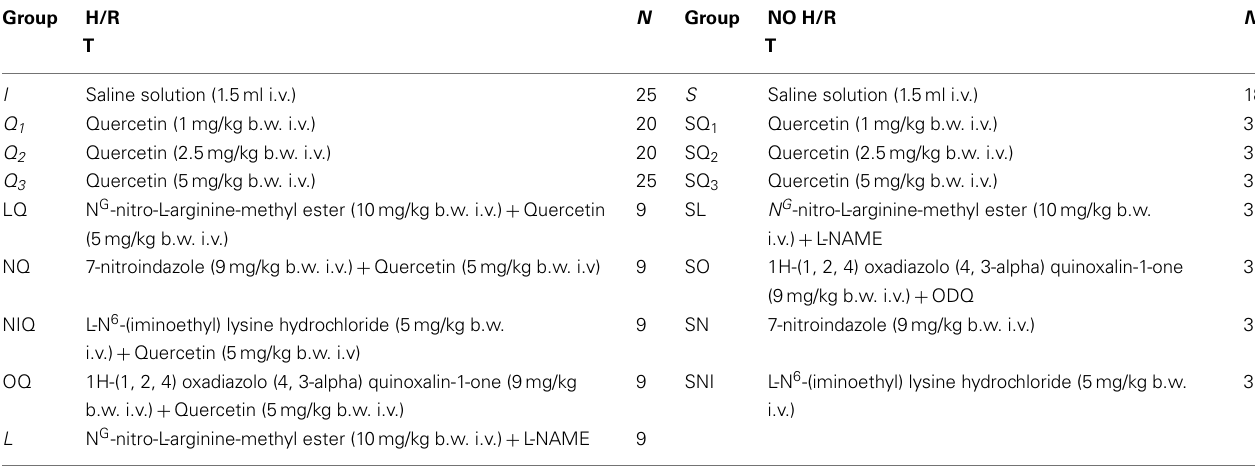
Table 2 | Drugs, doses and route of administration, type of treatment and time of administration in the different experimental groups. Group Drug Administration (total volume) Saline solution